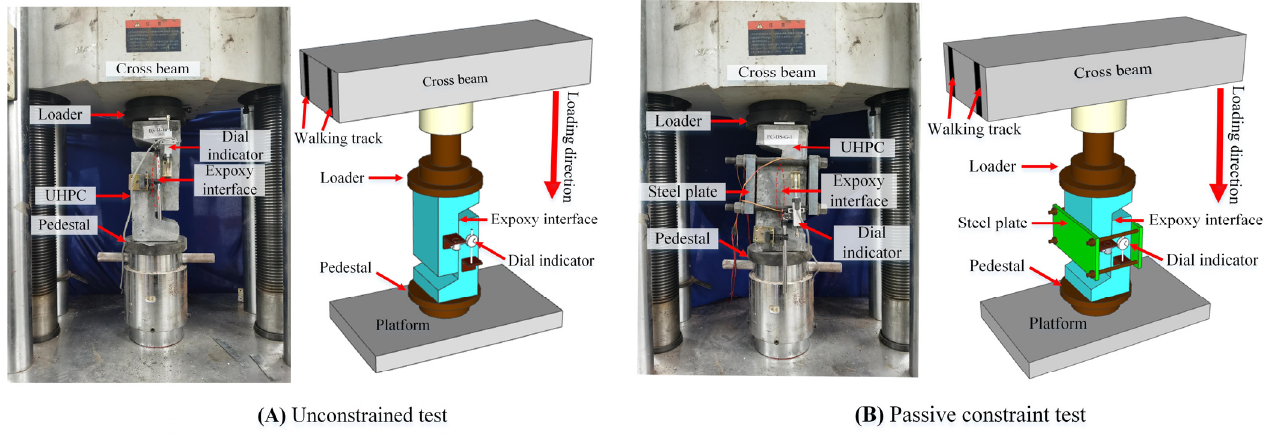
Figure 4. Test loading